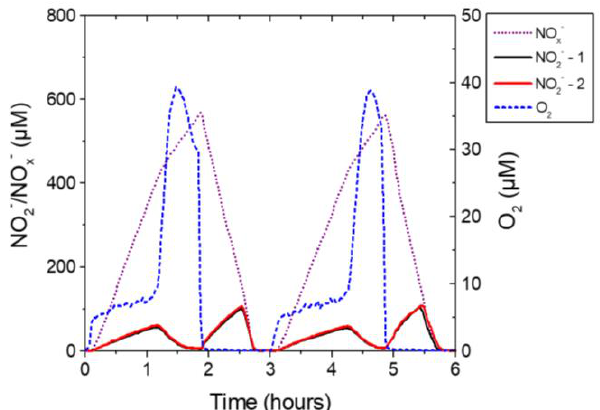
Figure 3. Cycles of O 2 , NO x − and NO 2 − in a pilot-scale wastewater treatment plant exposed to aeration cycles. NO x − rose upon start of aeration and decreased when aeration was stopped. Nitrite exhibited a more complex dependence of aeration/anoxia reflecting balance between NO 2 − producing and comsuming processes. Shown are traces from two NO 2 − sensors showing almost identical results. (Data was obtained from the laboratory of the presented authors).